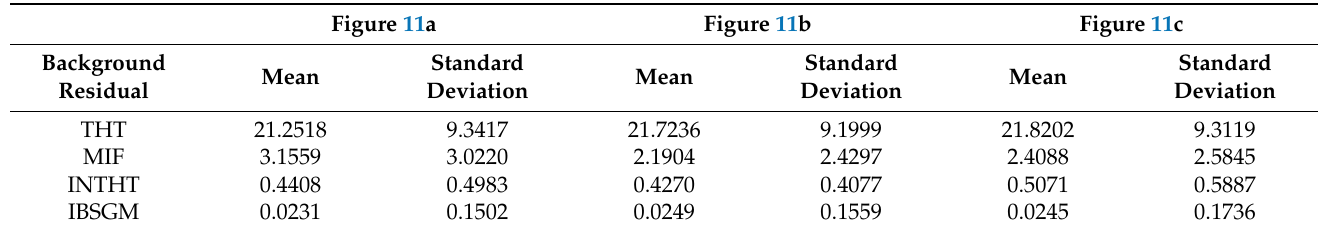
Table 2. Means and standard deviations of the residual image obtained by different methods.